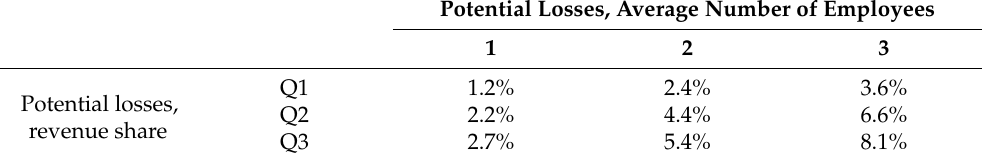
Table 7. The estimates of potential losses for three types of Asian Russian forest companies, divided by revenue